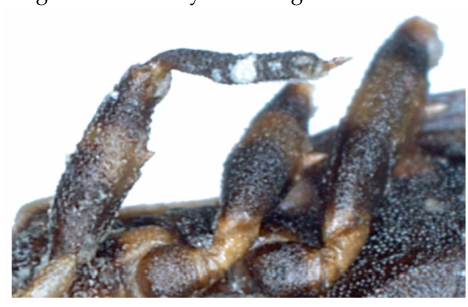
8.-Overall color black, with orange areas on connexivum and corium. Hemelytra membrane black, without reticular cells, color of veins not contrasting with cells